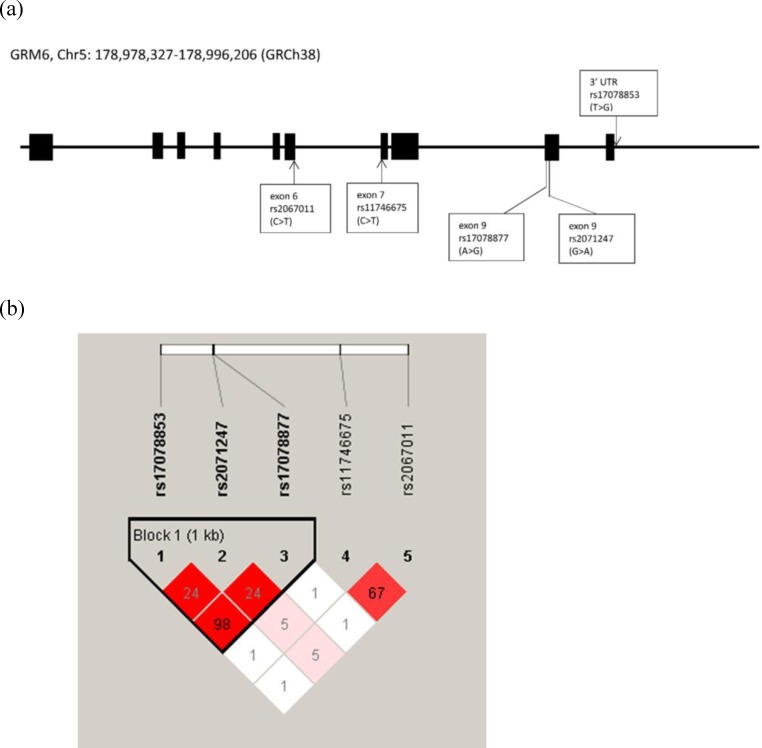
The genomic location and linkage disequilibrium pattern of the GRM6 genetic polymorphisms included in this study.Genomic locations of the genetic polymorphisms on chromosome 5. Haploview 4.2 software was used to estimate the linkage disequilibrium blocks. The R2 values were shown in squares; range from 0.01 to 0.98 and higher values indicate higher degree of correlation.